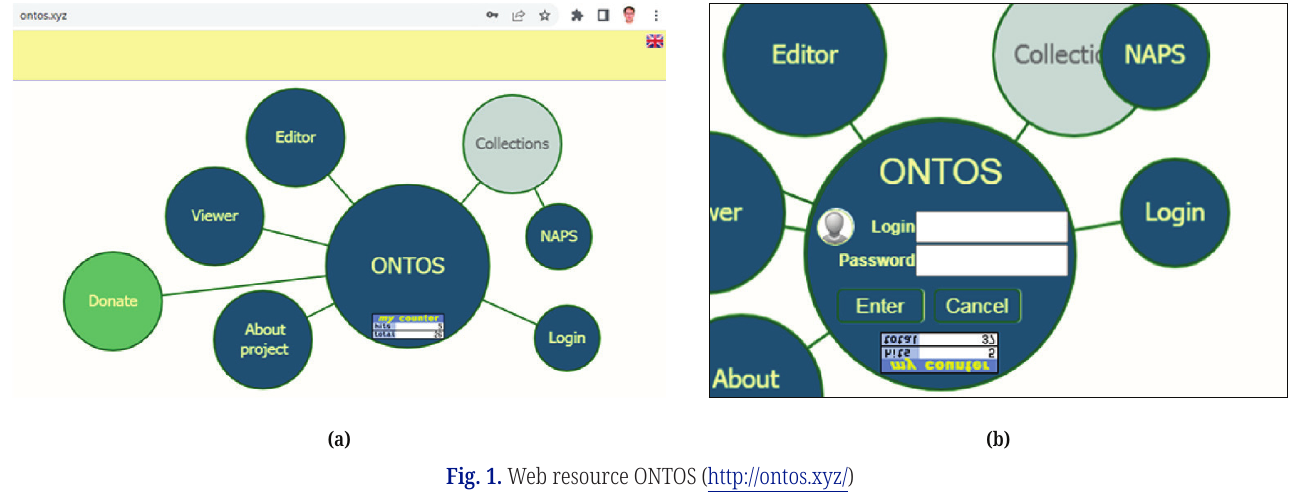
Fig. 1. Web resource ONTOS